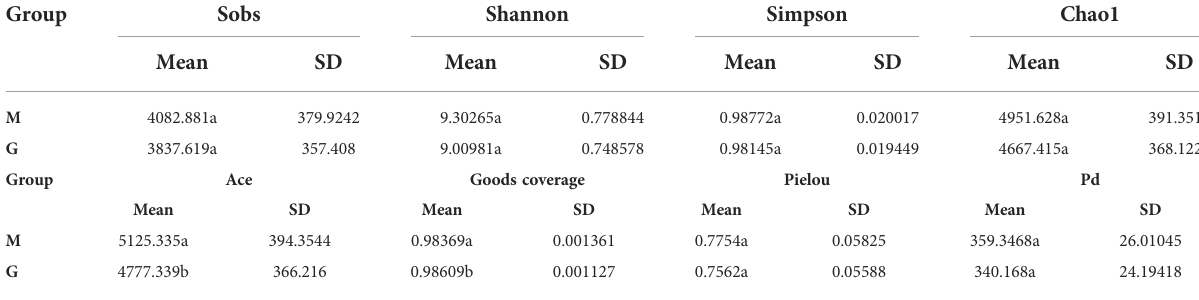
TABLE 1 Richness and alpha-diversity indices of the different ASVs between group M and